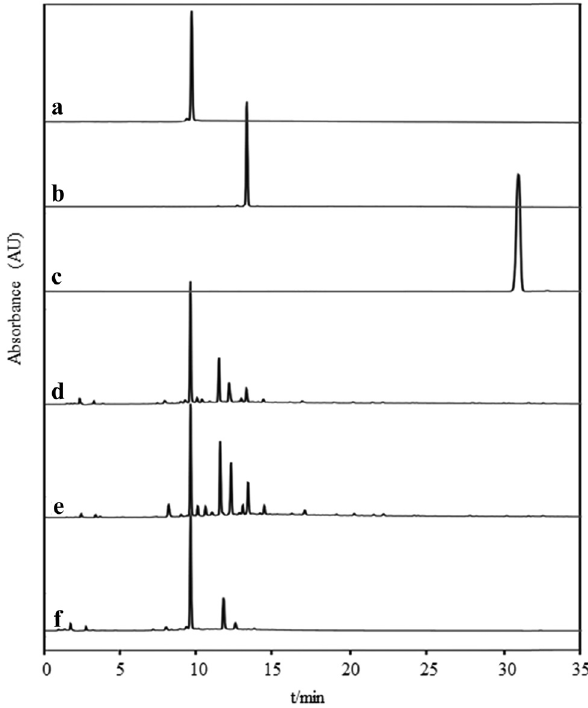
Figure 3: HPLC chromatograms of Standard - 1 ( Mangiferine ) ( a ) . Standard - 2 ( Purpurine ) ( b ) . Standard - 3 ( Charatine ) ( c ) . ME of R. cordifolia ( d ) . EF of R. cordifolia ( e ) . n - Butanol Fraction of R. cordifolia ( f )